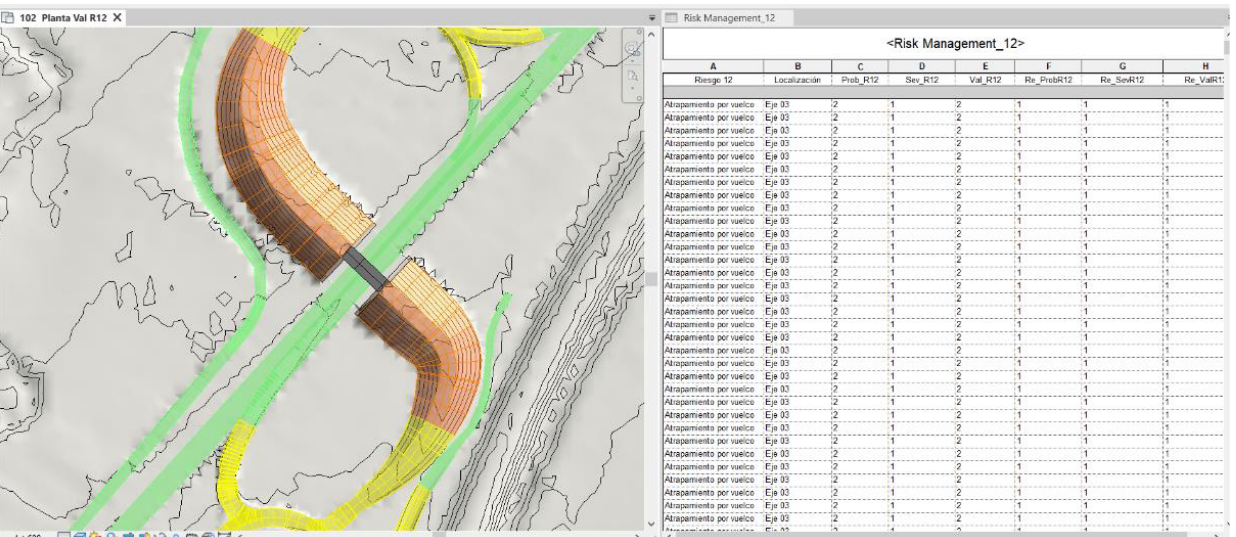
Figure 9. Analysis of specific works. This figure shows the interference between the execution of the refining task of the slopes and the bituminous mixture extension.